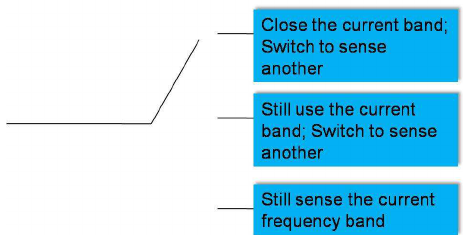
Figure 43. Three possible actions for each